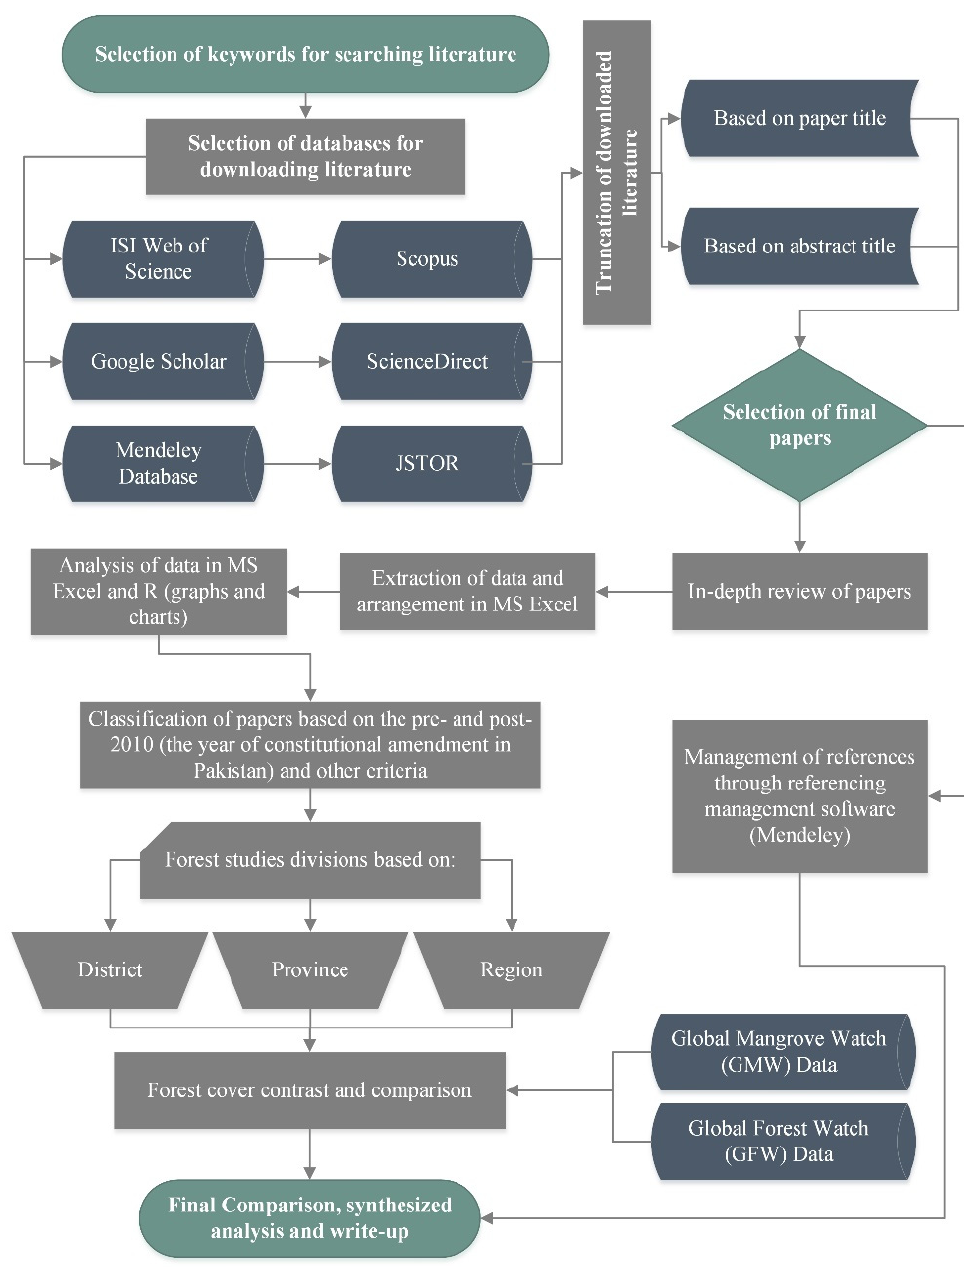
Figure 2. Methodological flowchart of the review.